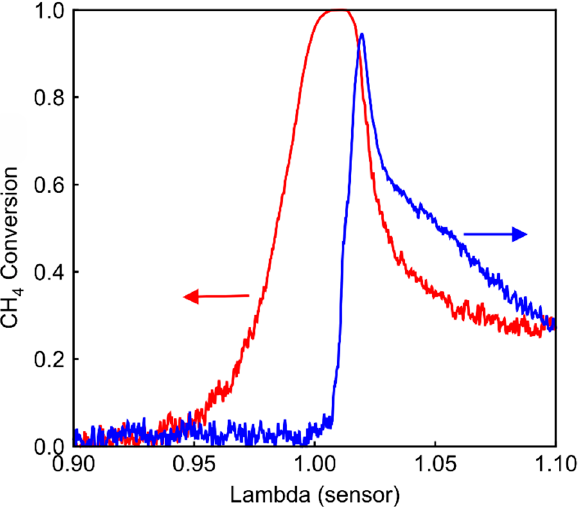
Figure 11. CH 4 conversion of the Pt/Pd/Rh catalyst during λ ramp-up (blue) and ramp-down (red) at 520 °C.